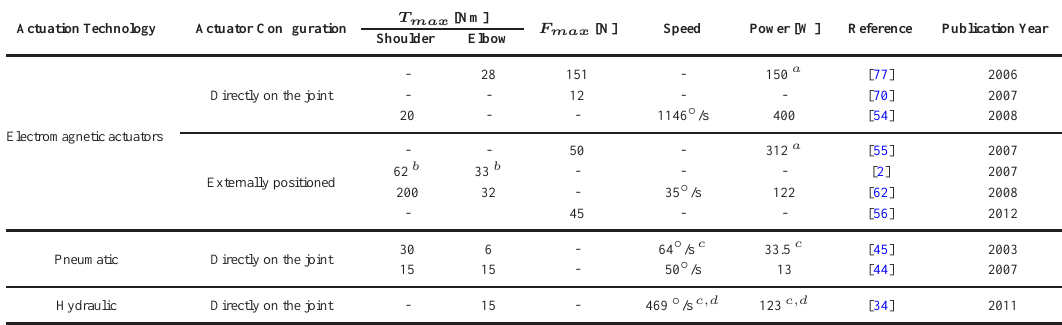
Table 2. Overview of the maximum torque/force of the RAS